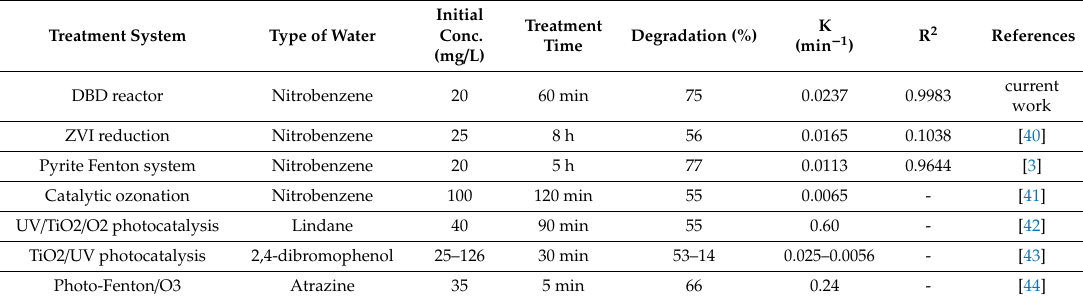
Table 2. The reaction kinetics comparison with other advanced oxidation processes